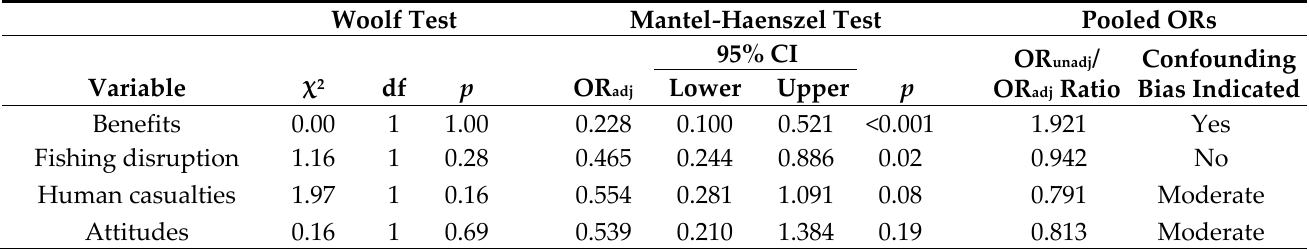
Table 5. According to Woolf, Mantel-Haenszel, and pooled odds ratios (ORs) results, while no